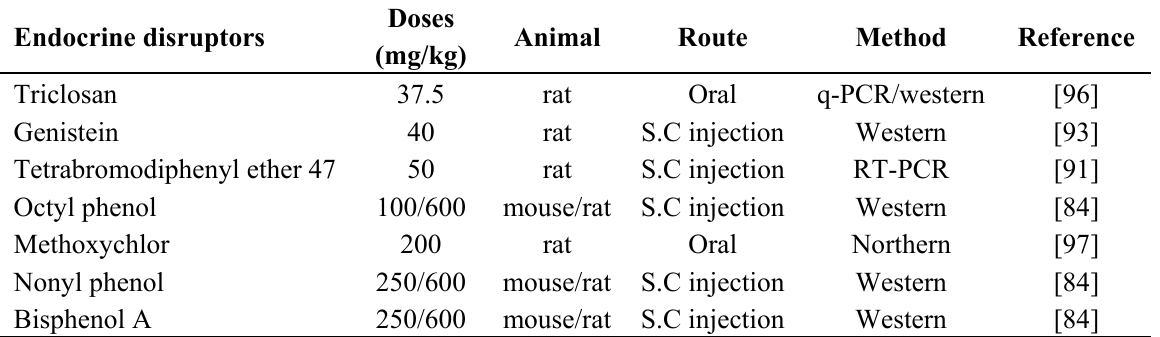
Table 2. Expression of uterine CaBP-9k in in vivo system by different EDs